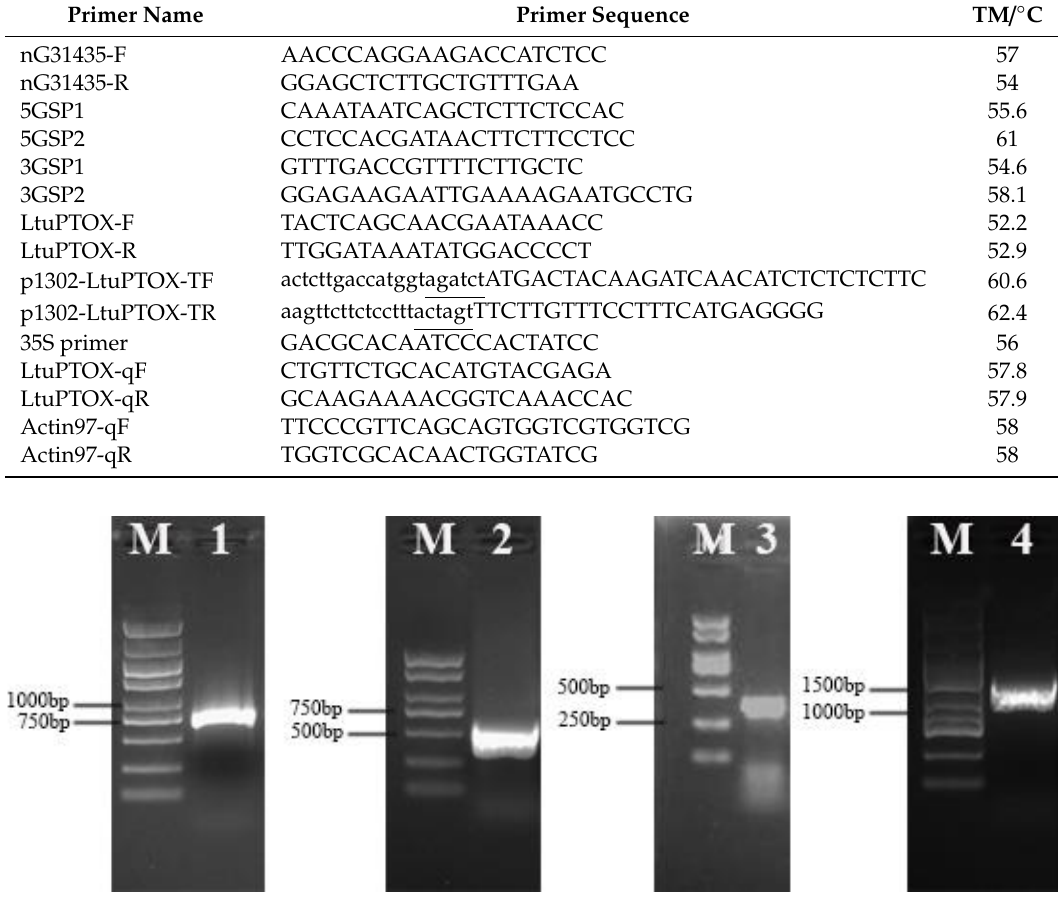
Figure A2. Isolation and detection of the LtuPTOX gene. DNA fragments were detected by 1.5% agarose gel. Lanes 1 ~ 3 represent the intermediate and untranslated regions of 5′ and 3′, respectively. Lane 4 is the open reading frame.